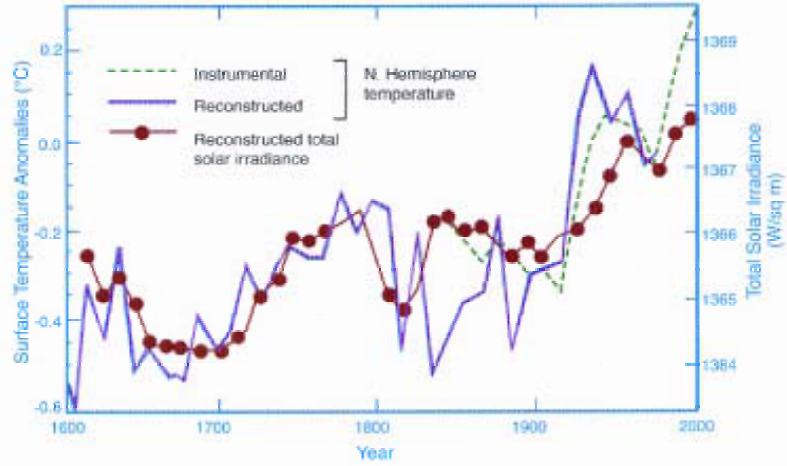
FIGURE 13. Comparison of observed surface temperature variation with that derived from models using proxy solar forcing. (From Lean et al. (1995) Reconstruction of solar irradiance since 1610: Implications for climate change, Geophys. Res. Lett .., 22, 3195–3198. With